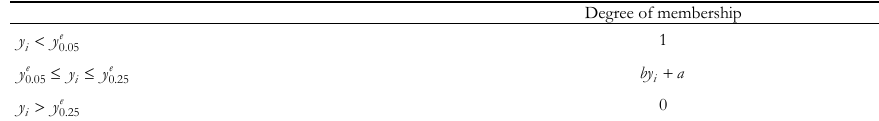
Degree of membership